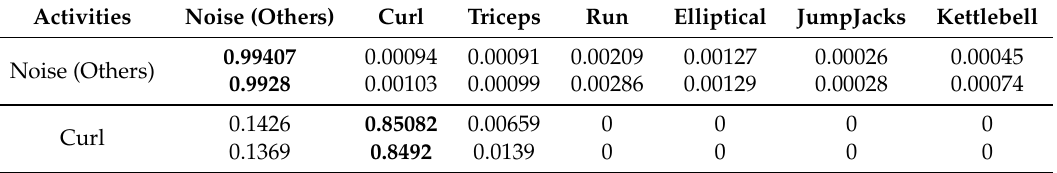
Table 5. Normalized confusion matrix for Experiment 5, i.e., six activities and one noise class representing all other activities and no activity periods from Dataset 2 under subject independent cross validation. Rows are true activities, and columns are predicted ones. Each entry has two values, where the top (bottom) value refers to the scenario with overlapping (non-overlapping)